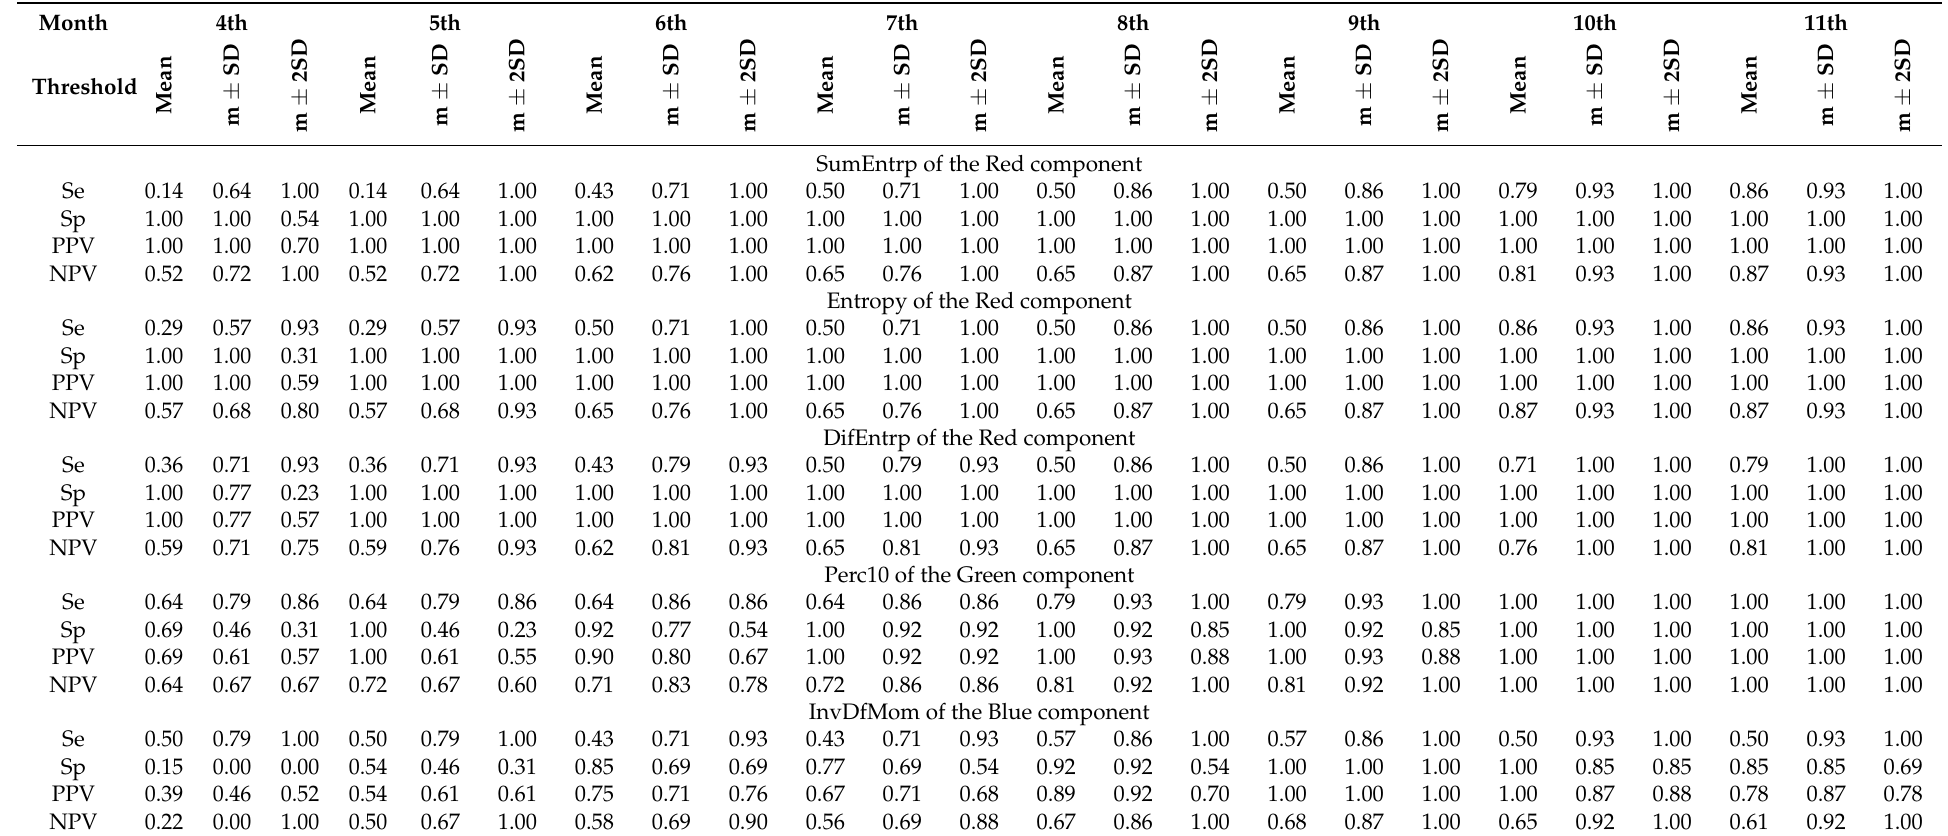
Table 1. Three thresholds (mean; mean ± SD (m ± SD); mean ± 2SD (m ± 2SD)) used to estimate the sensitivity (Se), specificity (Sp), positive predictive value (PPV), and negative predictive value (NPV) of pregnancy detection using the selected features of Histogram Statistics and Gray Level Co-occurrence Matrix in the RGB color